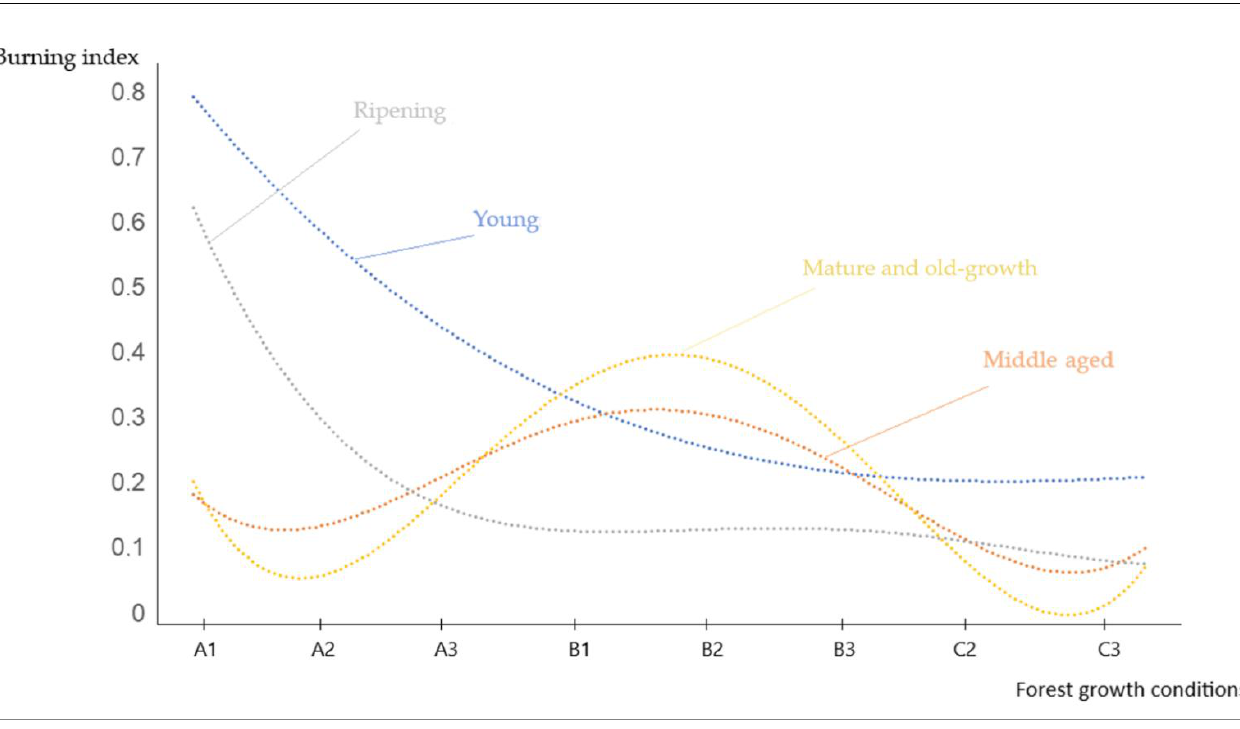
Figure 3. Burning indices of pine forests of different ages in various forest growth conditions. Table 7. Correlation matrix of forest stand characteristics in different forest growth conditions.